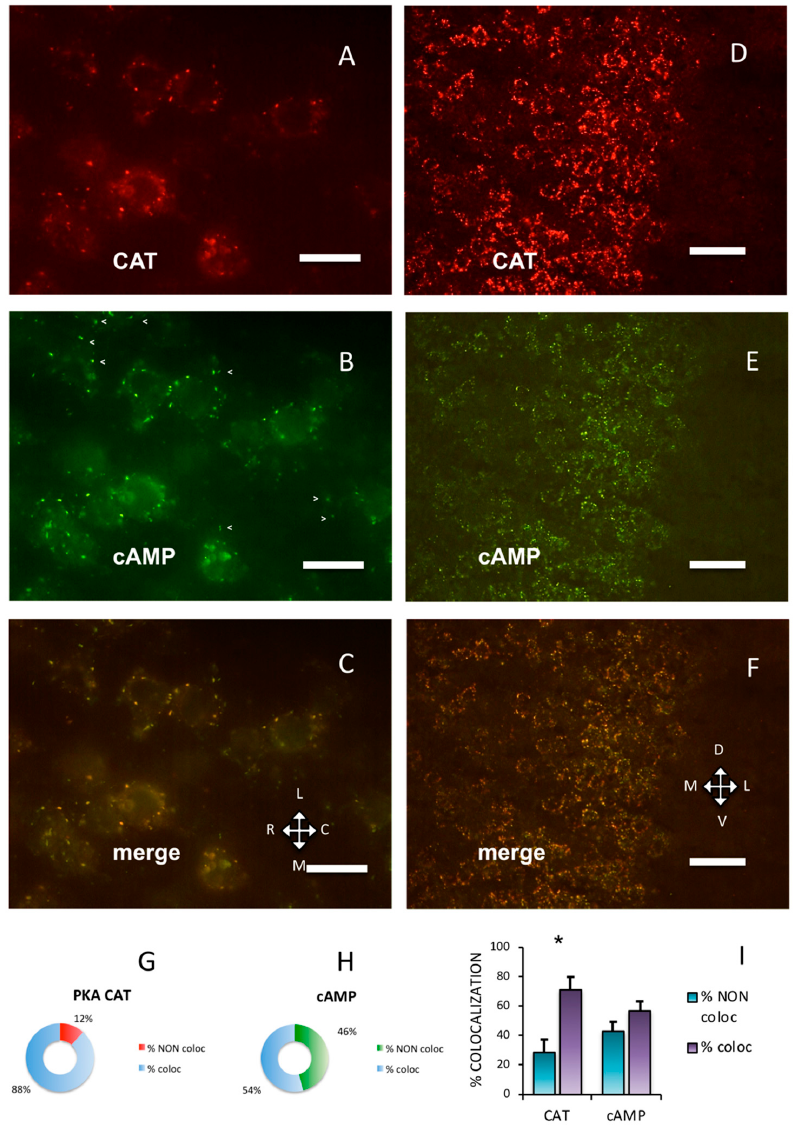
Figure 1. Protein kinase A (PKA) catalytic subunit colocalizes with cAMP in the cerebral parietal cortex. ( A ) Catalytic subunit immunolabeling (CAT) in the S1BF cortex, pia on the top. ( B ) Fluorescent Alexa488-cAMP (cAMP) in the same field. Arrowheads mark some cAMP-binding clusters in which no catalytic subunit is apparent (see Figure 1A,C). ( C ) Merge of A and B, showing superimposition (yellow). A – C : Horizontal section. L: lateral, M: medial, C: caudal, R: rostral. ( D ) Catalytic subunit immunolabeling at a lower magnification in S1BF cortex. Pia on the right. ( E ) Same field, fluorescent Alexa488-cAMP.( F )Mergeof D and E ,showingsuperimpositionofthetwosignals. D – F :Coronalsection. D: dorsal, V: ventral. Scale bar, 10 µ m ( A – C ), 25 µ m ( D – F ). G,H: quantification of superimposition in C ( n = 806). ( G ) Percentage of PKA catalytic immunolabeling colocalizing (% coloc, light blue, n = 255) or not (% NON coloc, red, n = 30) with fluorescent cAMP in C. ( H ) Percentage of fluorescent cAMP colocalizing (% coloc, light blue, n = 357) or not (% NON coloc, green, n = 164) with PKA catalytic immunolabeling in C. ( I ) Percentage of colocalization (coloc, violet) and non-colocalization (NON coloc, blue) of catalytic immunolabeling (CAT) and fluorescent Alexa488-cAMP (cAMP) in three di ff